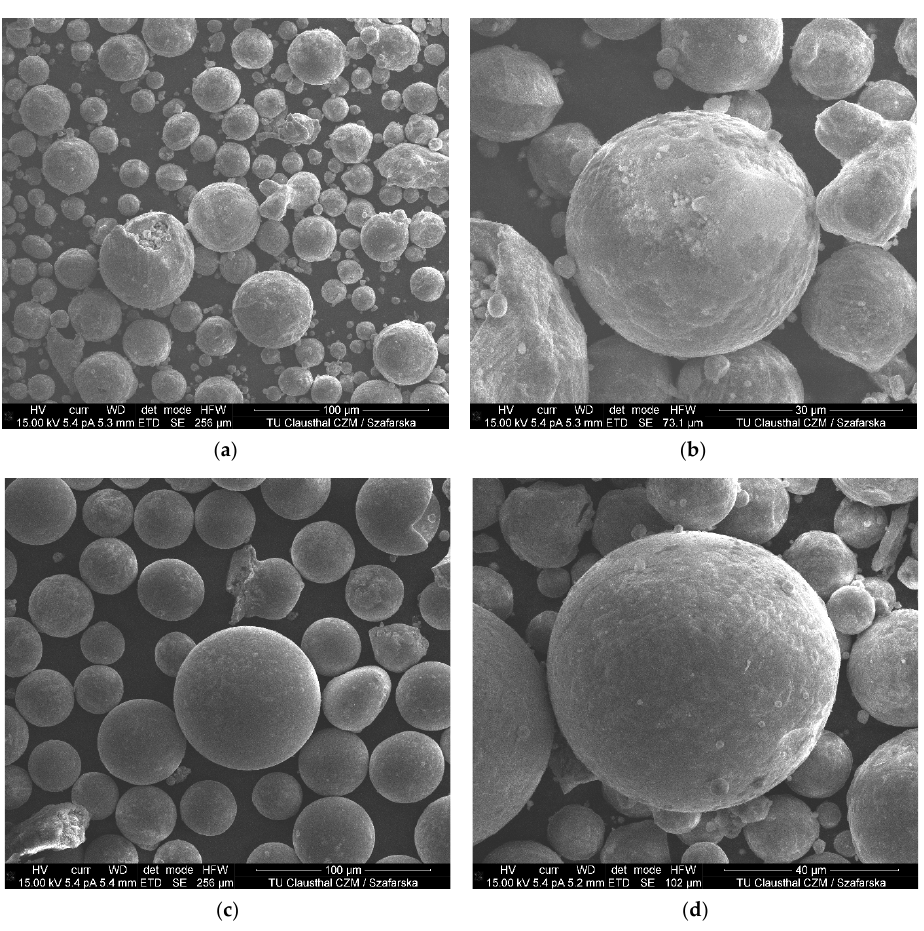
Figure 13. SEM micrographs of wire arc copper particles: ( a , b ) formed upon spraying in air and ( c , d ) in silane ‐ doped nitrogen formed. ( c , d ) in silane-doped nitrogen